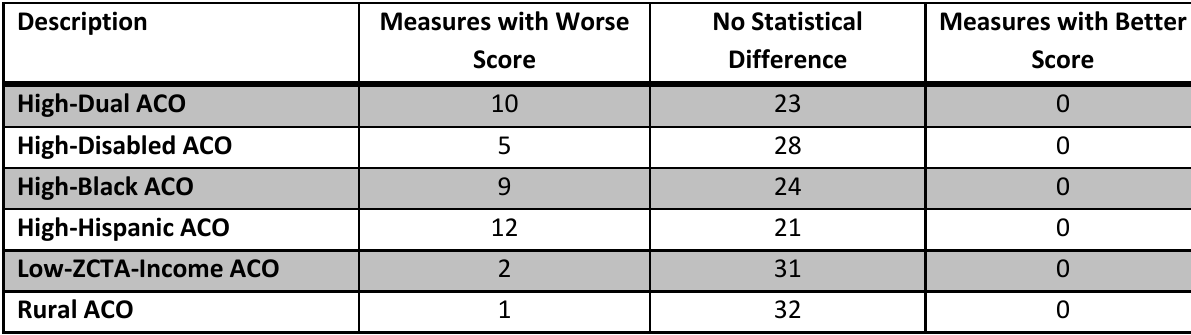
Table 9.9: Summary of Quality Performance by ACO Social Risk Composition, 2014